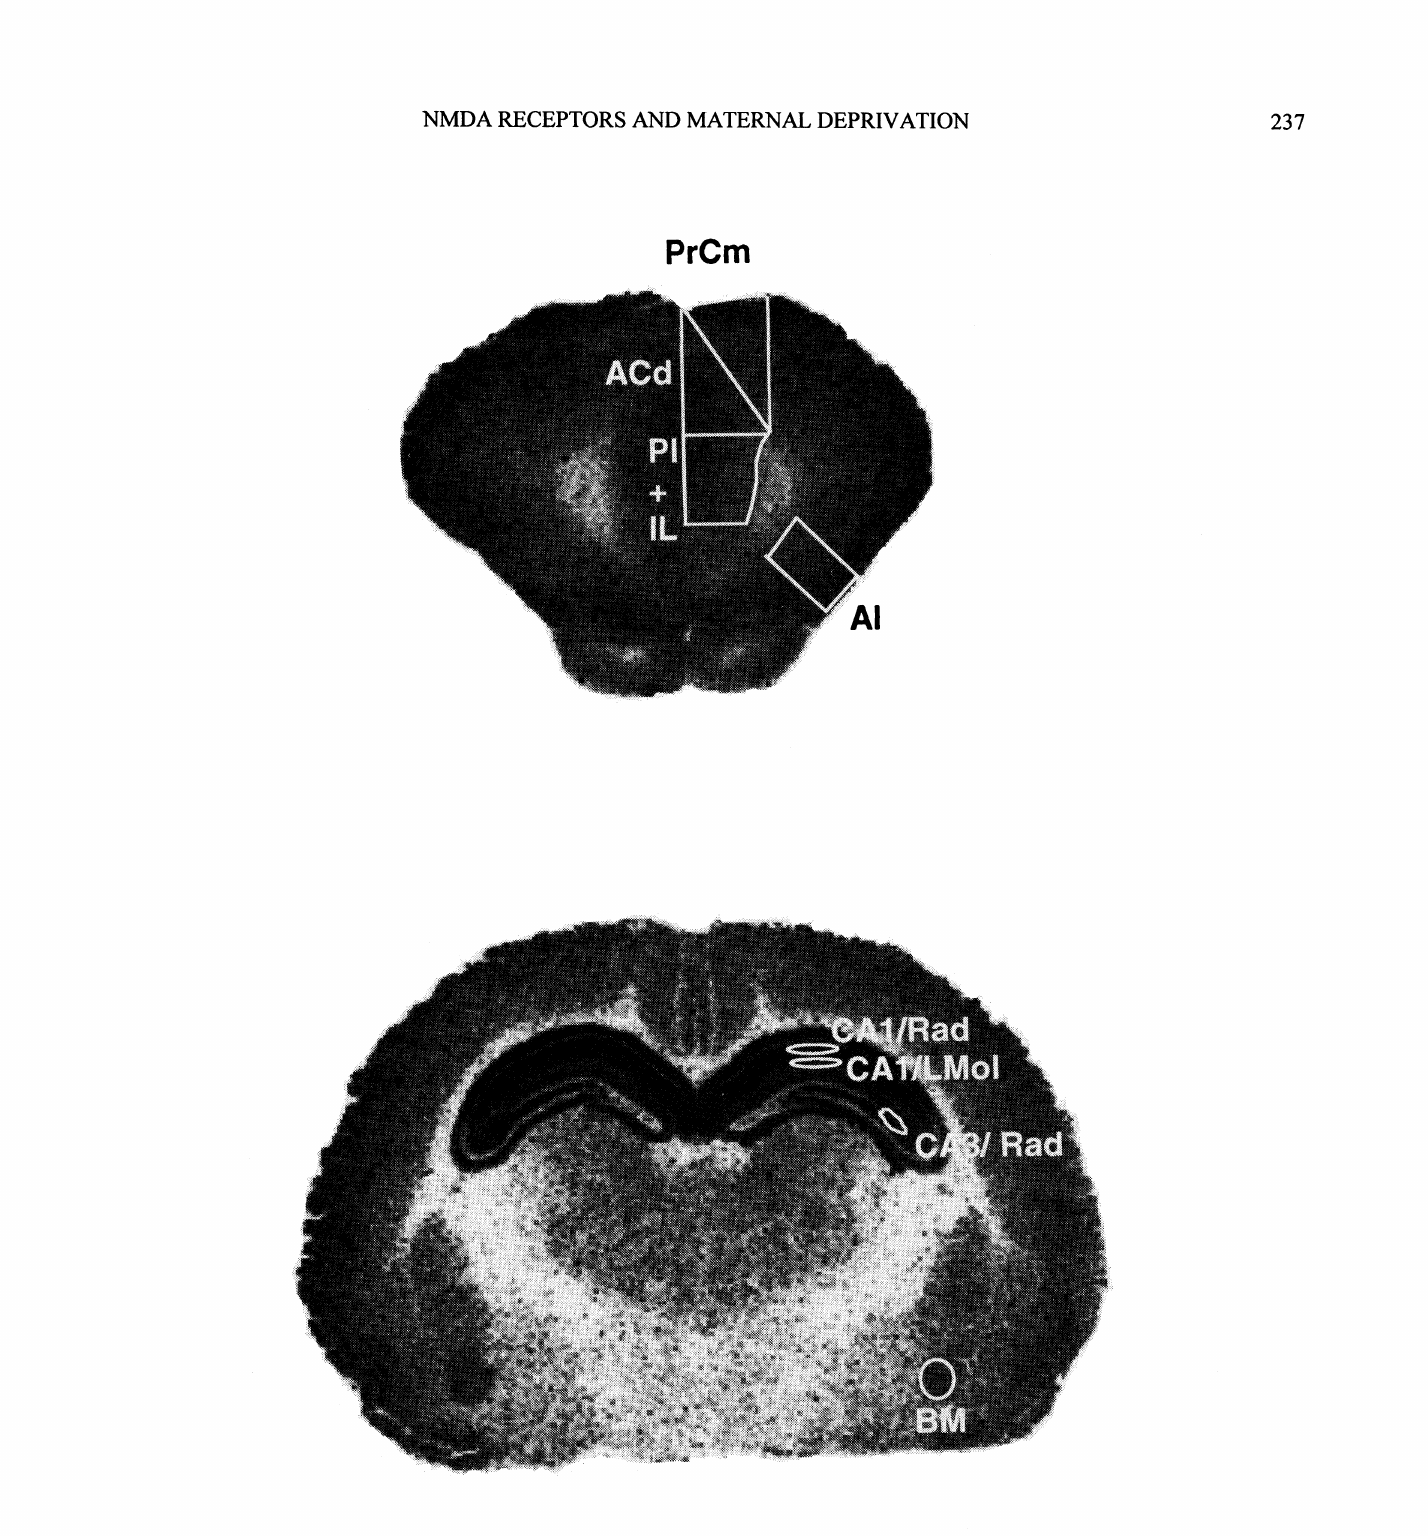
Fig. 2" Topographic localization of NMDA receptors in the forebrain of 2-wk-old Octodon degus demonstrated by binding to the antagonist [3H]-MK801. Frontal sections of anterior (top) and more posterior (bottom) levels of the forebrain. In the outlined areas, receptor densities were quantified using densitometric image analysis. PrCm, precentral medial cortex; ACd, anterior cingulate cortex; PL+IL, pre- and infra-limbiccortex; AI, anterior insular cortex; CA1/Rad, stratum radiatum of CA1; CA1/LMol, stratum lacunosum moleculare of CA1; CA3/Rad, stratum radiatum of CA3; BM, basomedial amygdaloid